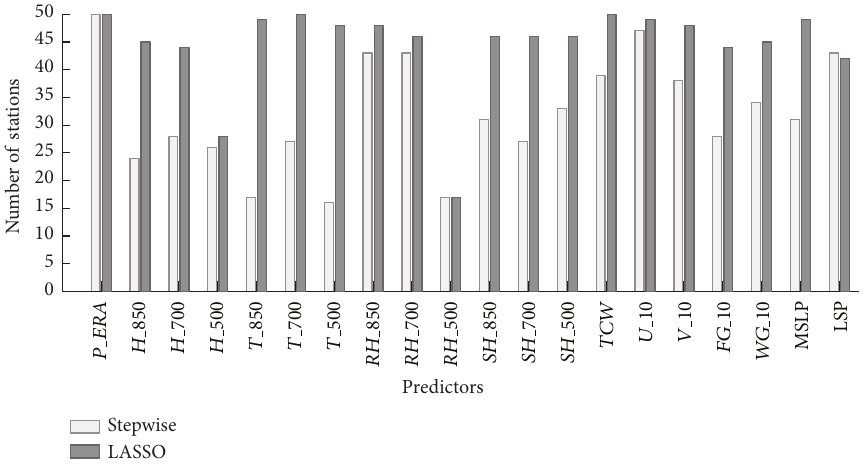
Figure 4: Selected variables in Stepwise and LASSO for dry/wet days